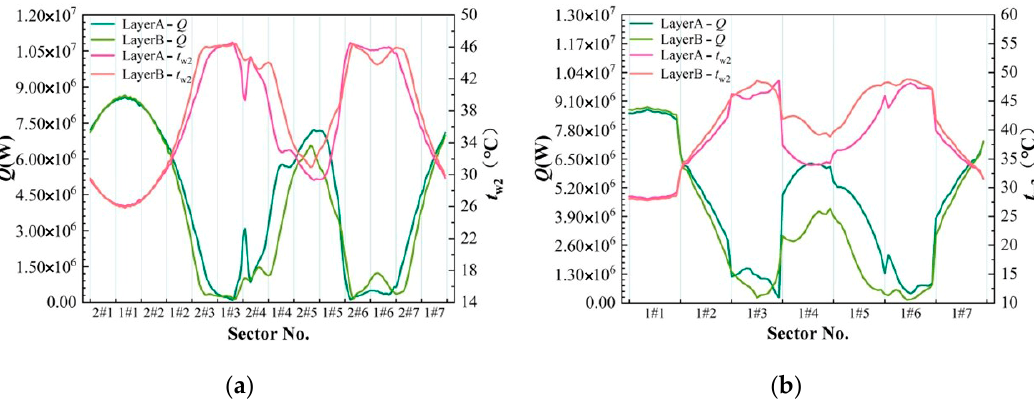
Figure 8. Heat rejections and water outlet temperatures of double-layer cooling deltas under a typical crosswind of 12 m/s. ( a ) In the case of 2 units; ( b ) in the case of 1 unit.